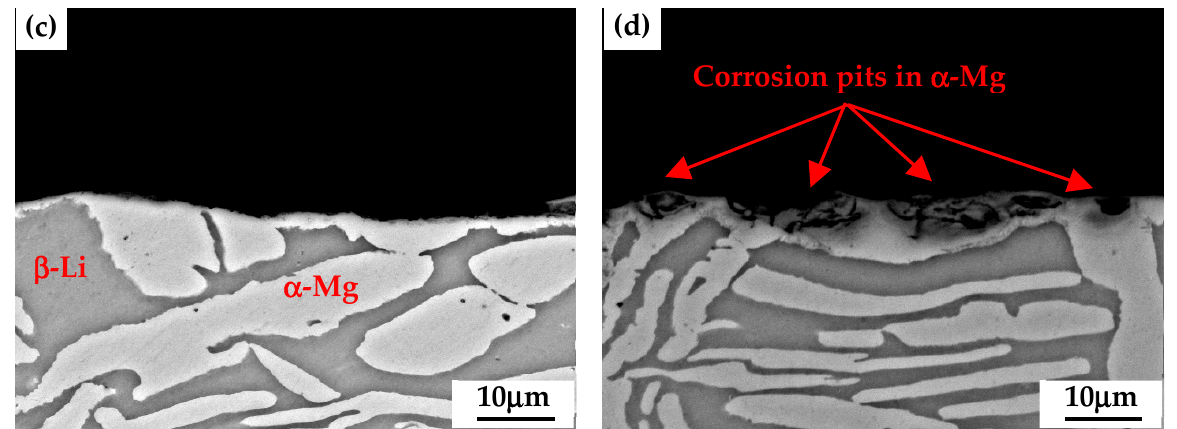
Figure 9. SEM observations to the cross-sectional morphologies of the immersed samples in solu- tions of: ( a ) 0.9 wt.% and ( b ) 3.5 wt.% NaCl solutions for 4 h, respectively. Images ( c ) and ( d ) are high magnification observations to the areas squared in images ( a ) and ( b ), respectively.